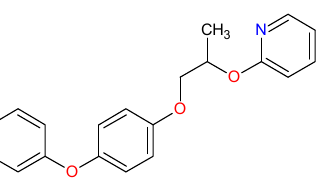
Figure 1. 2D structural formula of pyriproxyfen (2-[1-methyl-2-(4-phenoxyphenoxy) ethoxy] pyridine).